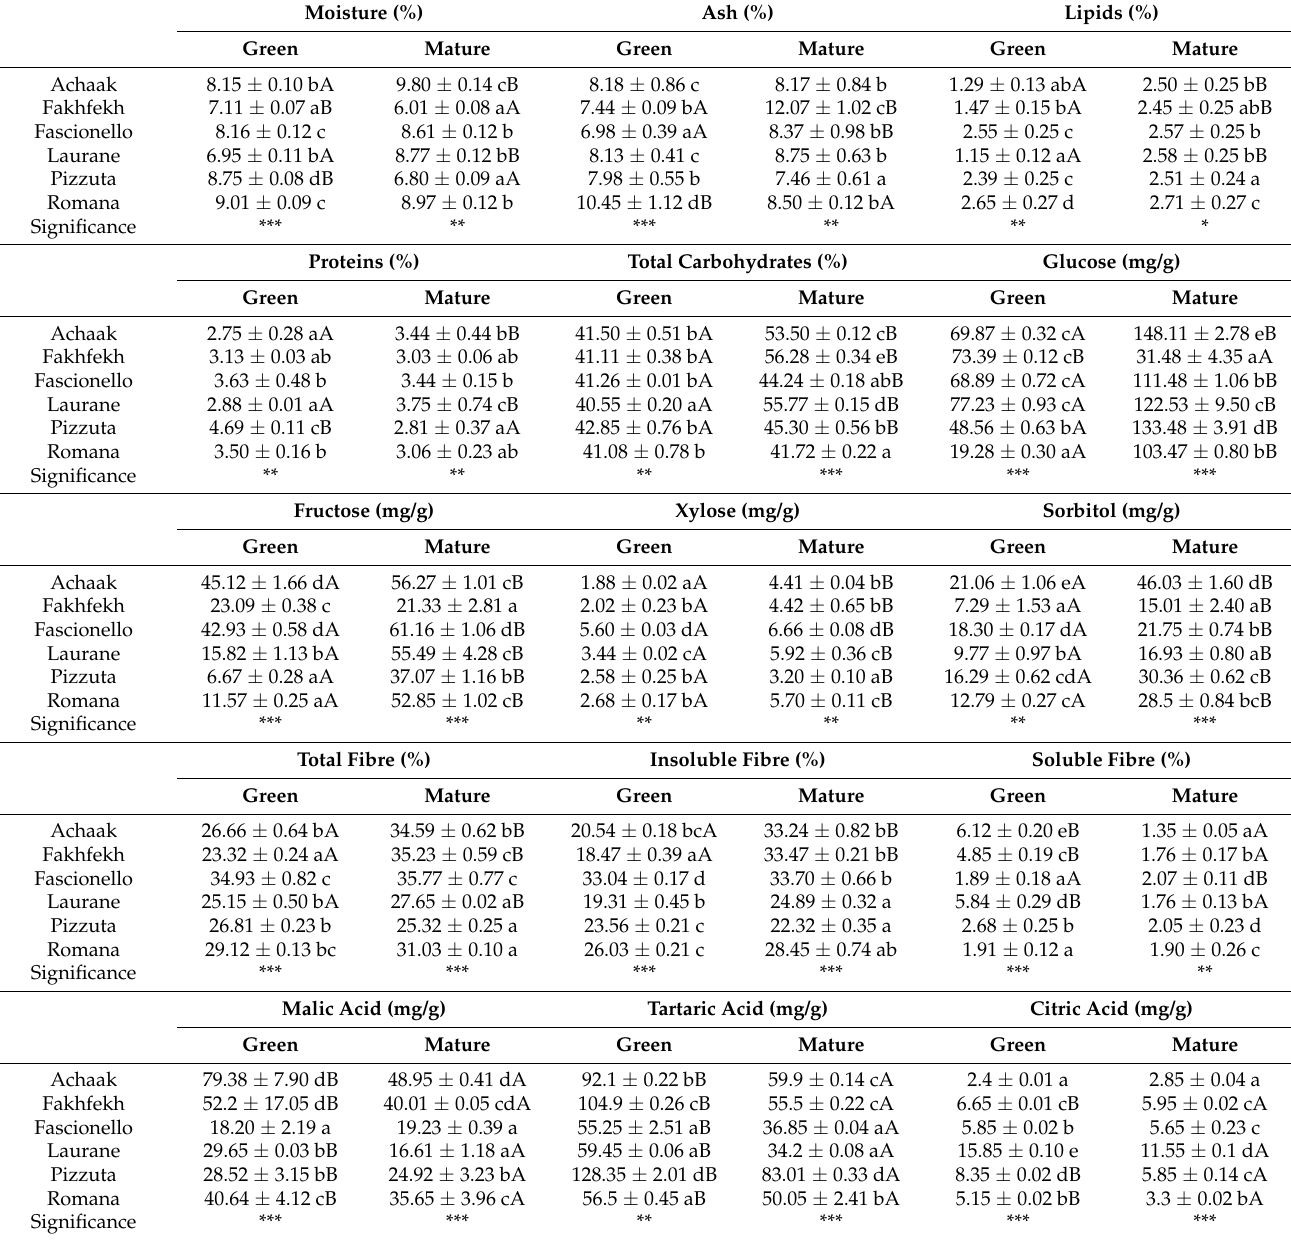
Table 2. Chemical composition of green and mature AHs and results of variance analysis with Duncan’s test ( p < 0.05) performed between the almond varieties and the two harvesting times (green and